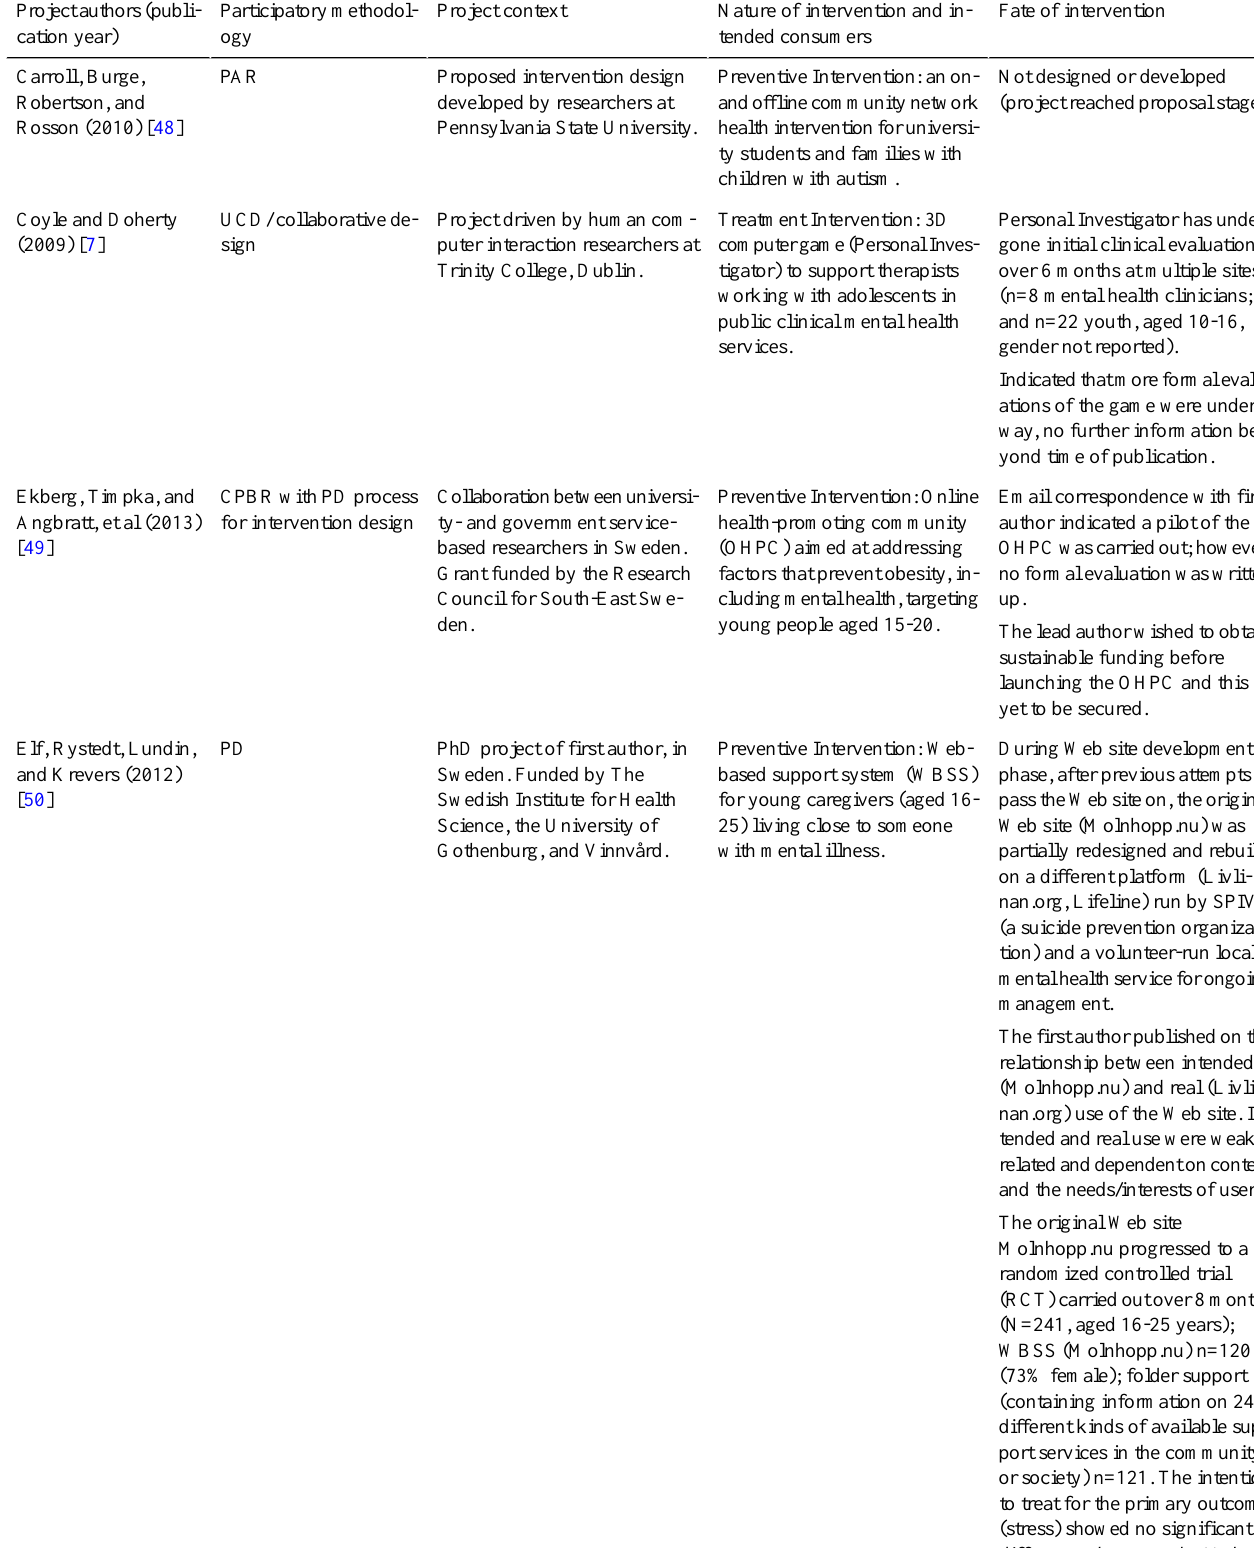
Table 1. The 17 projects included in the literature review.